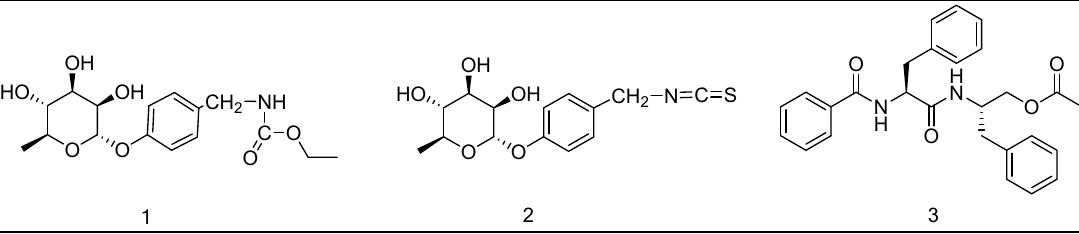
Figure 2. Molecular structure of compounds 1 – 3 .